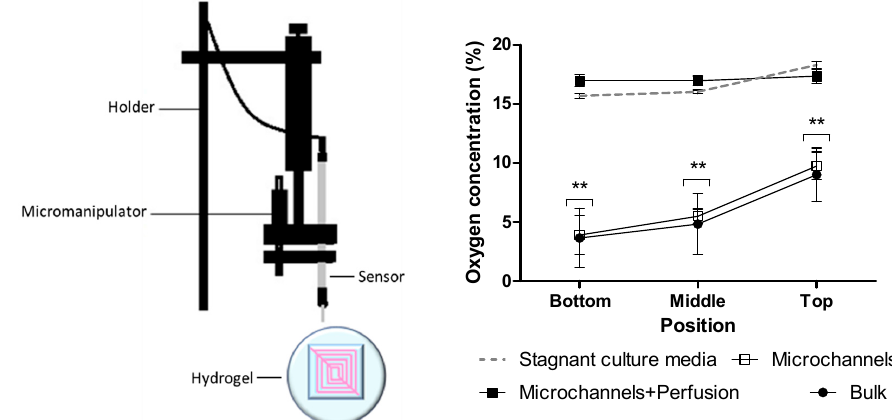
Figure 2. (Left ) Schematic of the apparatus for measuring oxygen concentrations. ( Right ) Oxygen levels at different heights of the constructs with and without perfusion, 24 h after bioprinting of the constructs. “Microchannels” refers to the constructs with microchannels and without perfusion; “Microchannels + Perfusion” refers to the constructs with microchannels and perfusion; “Bulk” refers to the constructions without channels. All constructs were seeded with a cell density of 8 million cells / mL ( n = 3, data represents mean ± SEM). ** p < 0.01 when compared to culture media. When perfusion was turned o ff , an exponential drop in oxygen concentration took place.